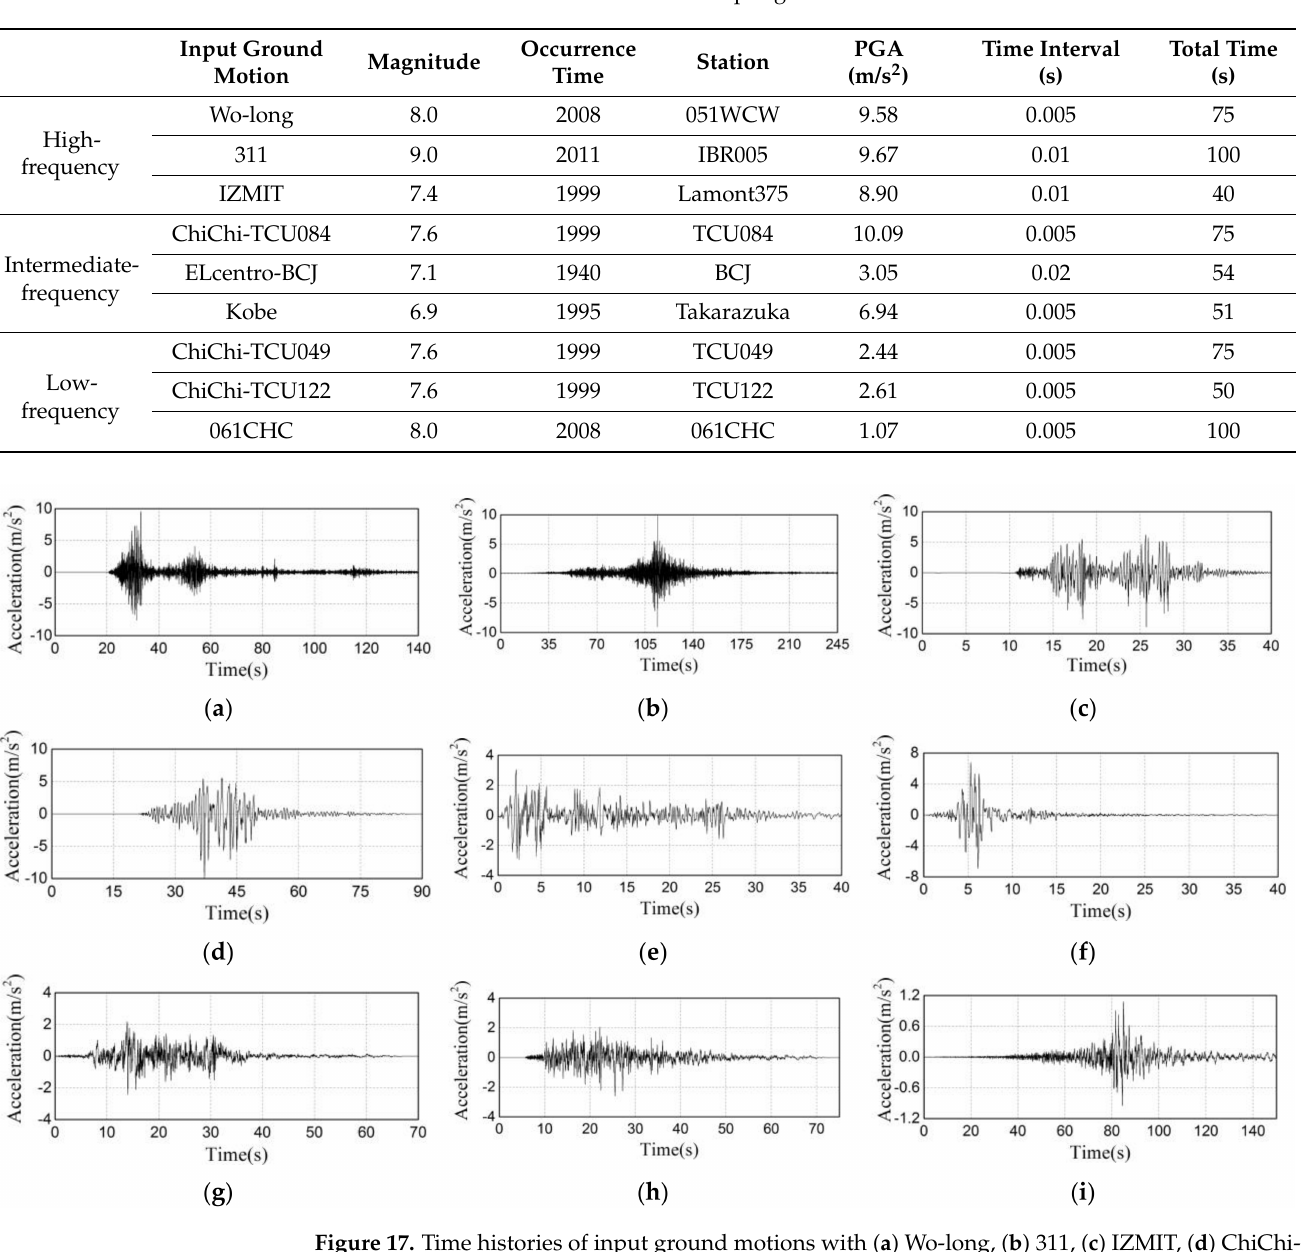
Table 3. The detailed information of the input ground motions.